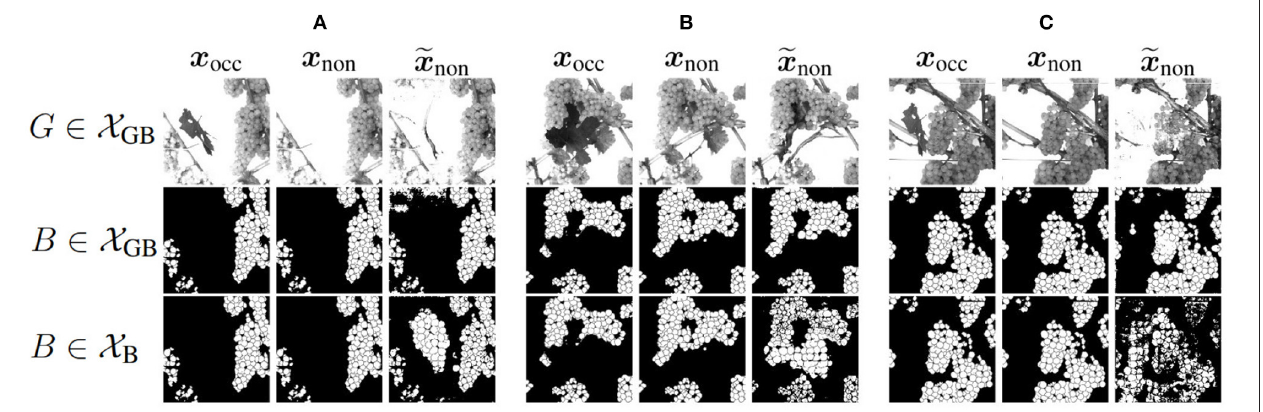
x FIGURE 8 | Visual representation of generated test results non in the non-occluded domain of Dataset 1 including GB channel and Dataset 2 including only B e channel in comparison to reference target output x non of the non-occluded domain and input x occ of the non-occluded domain. Three example (A–C) are shown. The first row shows the G channel of X GB . The second row illustrates the mask B of X GB . The last row represents the corresponding result of X B